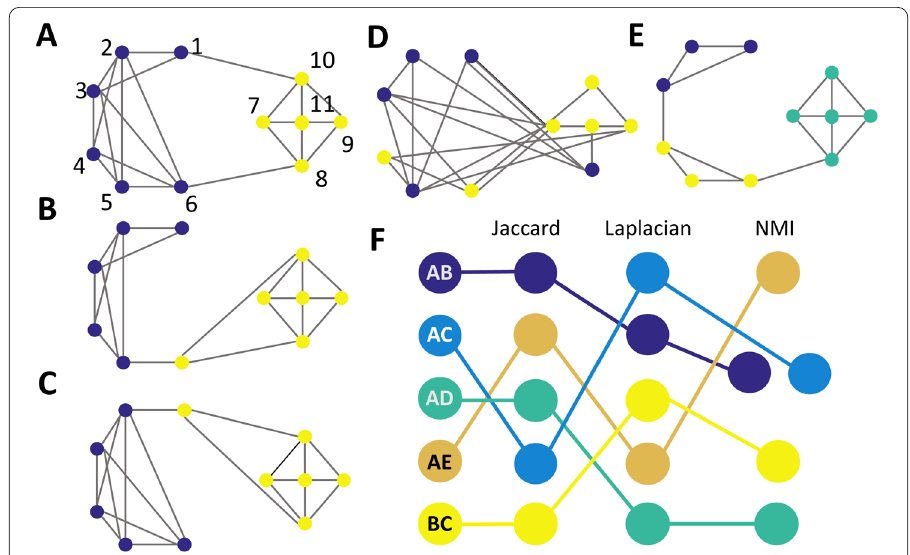
Figure 1 Here we show five networks whose nodes are coloured according to their communities found using modularity. We illustrate the different behaviours of three network comparison methodologies: the Jaccard distance (graph editing), the Spectral distance (eigenvalues) and the NMI distance (partitions). Subfigure ( F ) shows the ranking of these similarity metrics for network pairs from closest (top) to furthest (bottom). Notice that standard community comparison metrics like NMI do not differentiate between pair A–B and pair A–C since they ignore the underlying structure and consider exclusively the